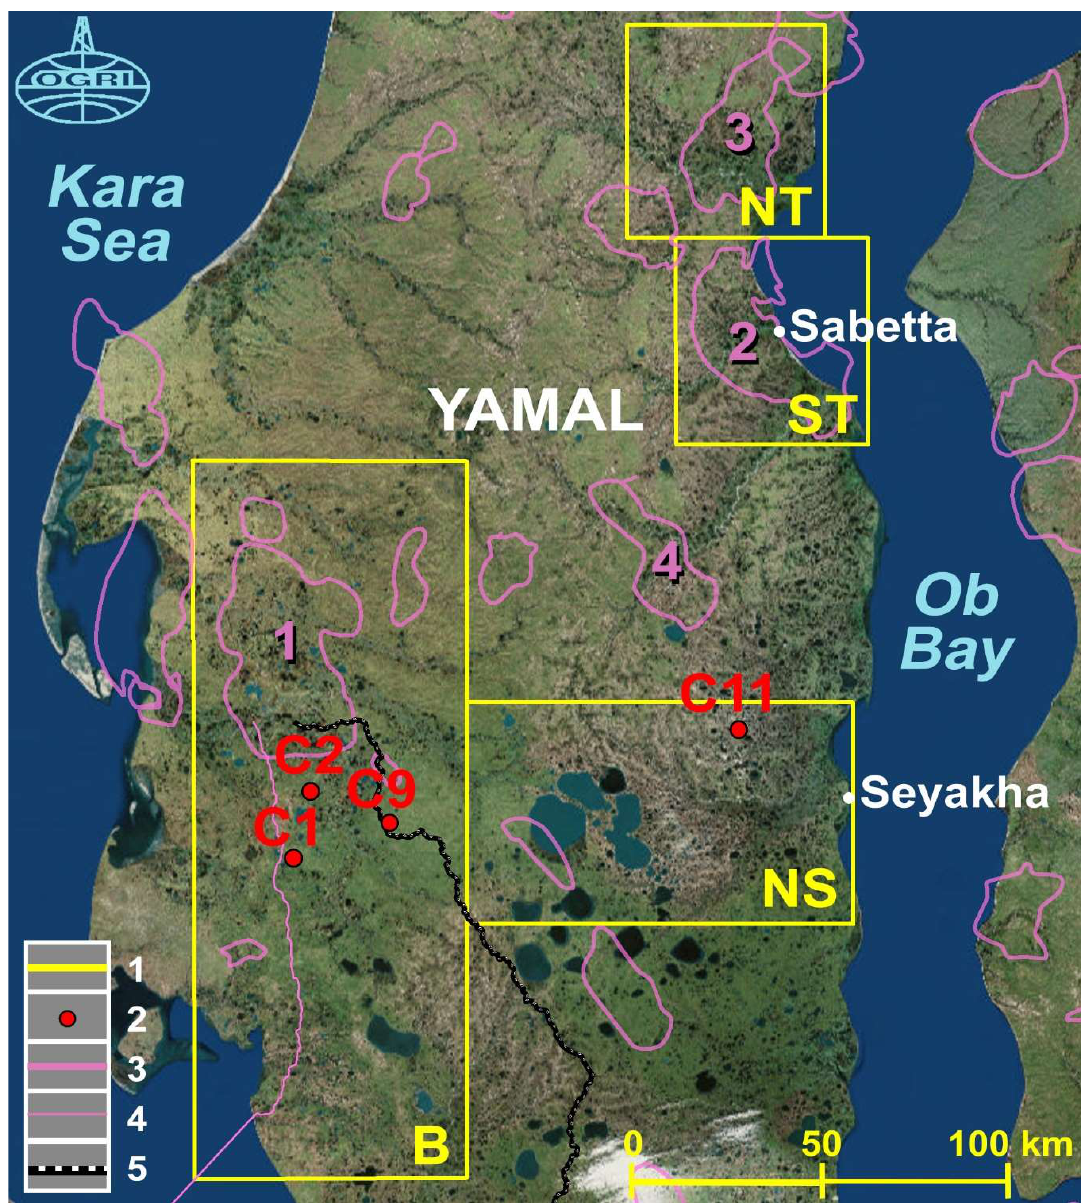
Figure 1. Gas blowout craters in the central part of the Yamal Peninsula. (1) Areas of detailed studies of Oil and Gas Research Institute of Russian Academy of Sciences (OGRI RAS): B, Bovanenkovo; ST, South Tambey; NT, North Tambey; NS, Neito-Seyakha. (2) Craters of gas blowouts C1, C2, C9 and С11. (3) Gas and gas condensate fields including those marked with pink color: Bovanenkovo (1), South Tambey (2), North Tambey (3) and West Seyakha (4). (4) Gas pipeline Bovanenkovo-Ukhta. (5) Railroad. Basemap—ESRI standard imagery.